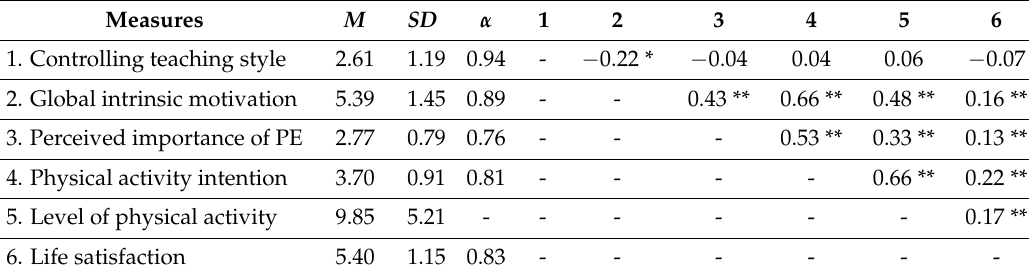
Table 1. Descriptive statistics and correlations among